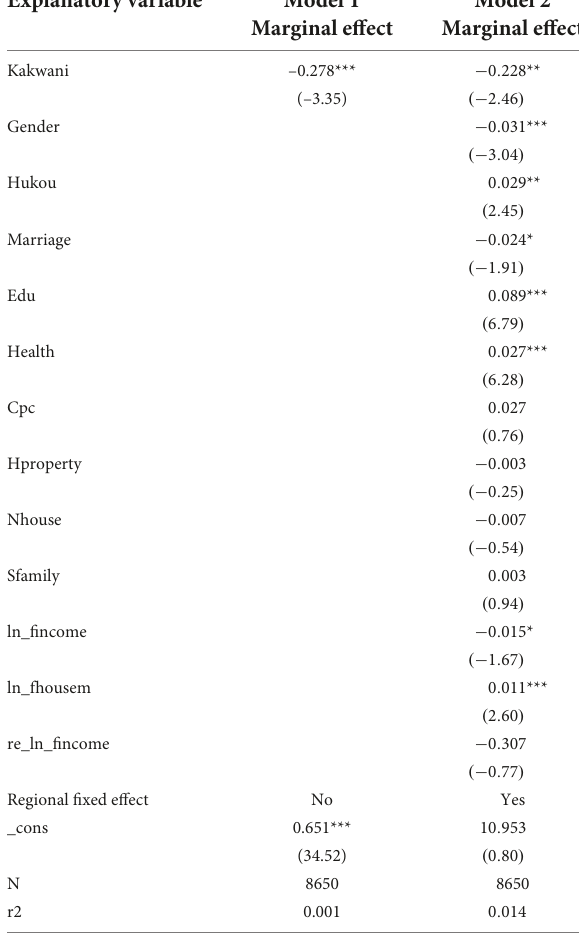
TABLE 2 Correlation between income relative deprivation and rationality of sleep